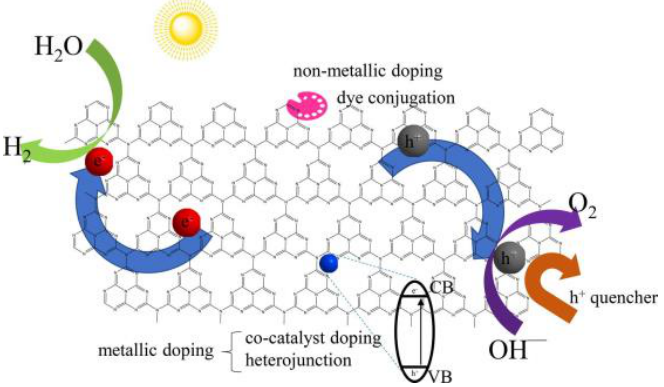
Figure 11. Scheme for a one-pot thermal preparation of amino-functionalized ultrathin nanopo-